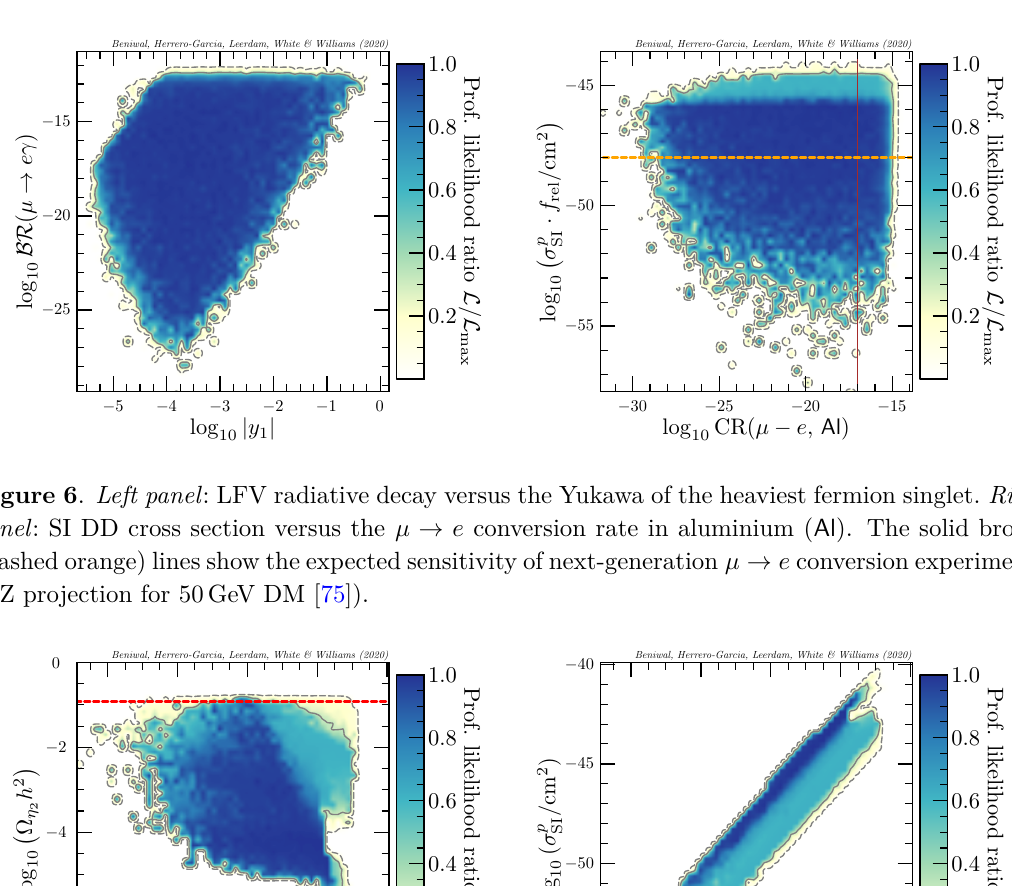
- η coupling, λ , see eq. (3.33) for more 2 2 eff